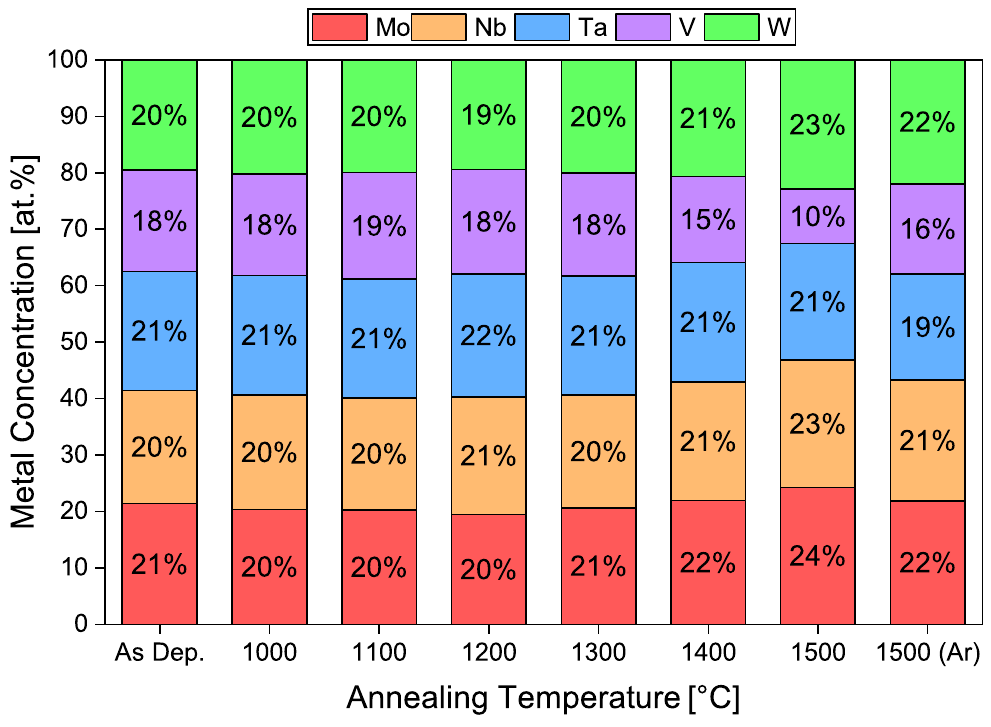
Figure 1. SEM top-view images of MoNbTaVW thin films on Al 2 O 3 substrates in as-deposited state and after annealing in vacuum and in Ar atmosphere.